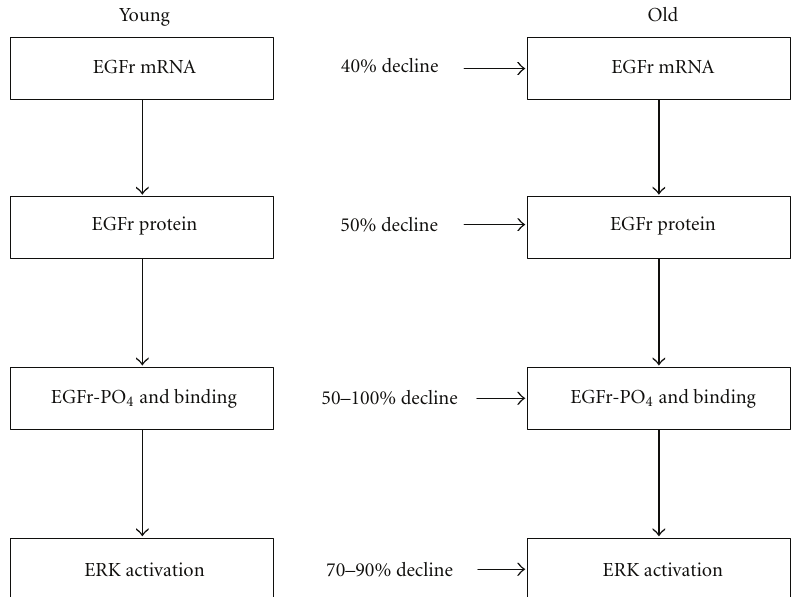
Figure 6: E ff ect of age on liver EGF activation, phosphorylation, and subsequent activation of the extracellular receptor kinase (ERK). Data derived from